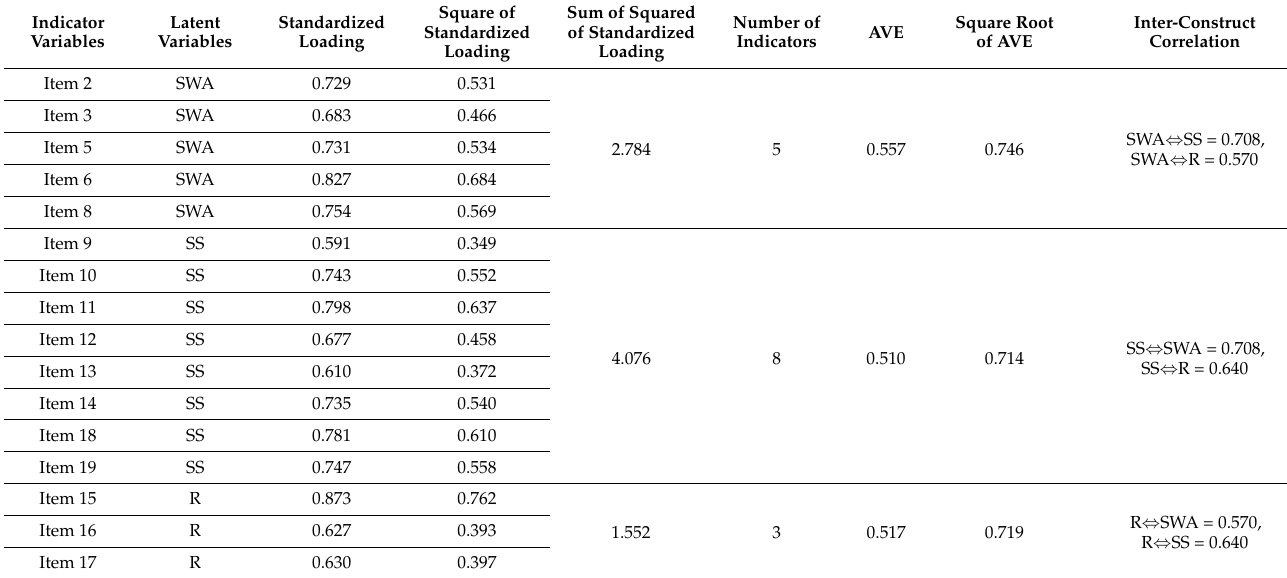
Table 6. The convergent and discriminant validity of the Malay version of the Shame and Stigma Scale (SSS-M).